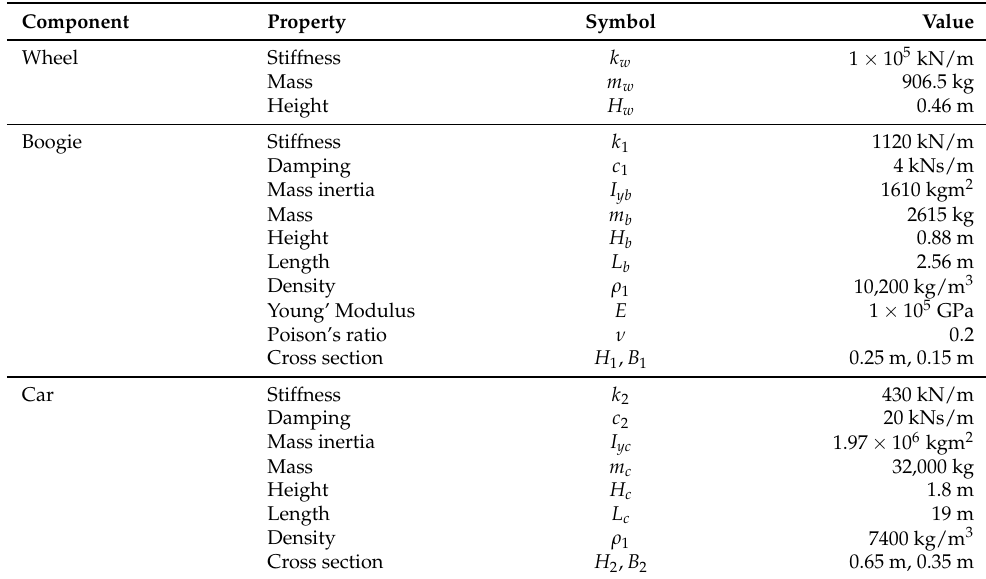
Figure 3. Schematic illustration of the train model and the parameters. Table 1. Mechanical properties of the train